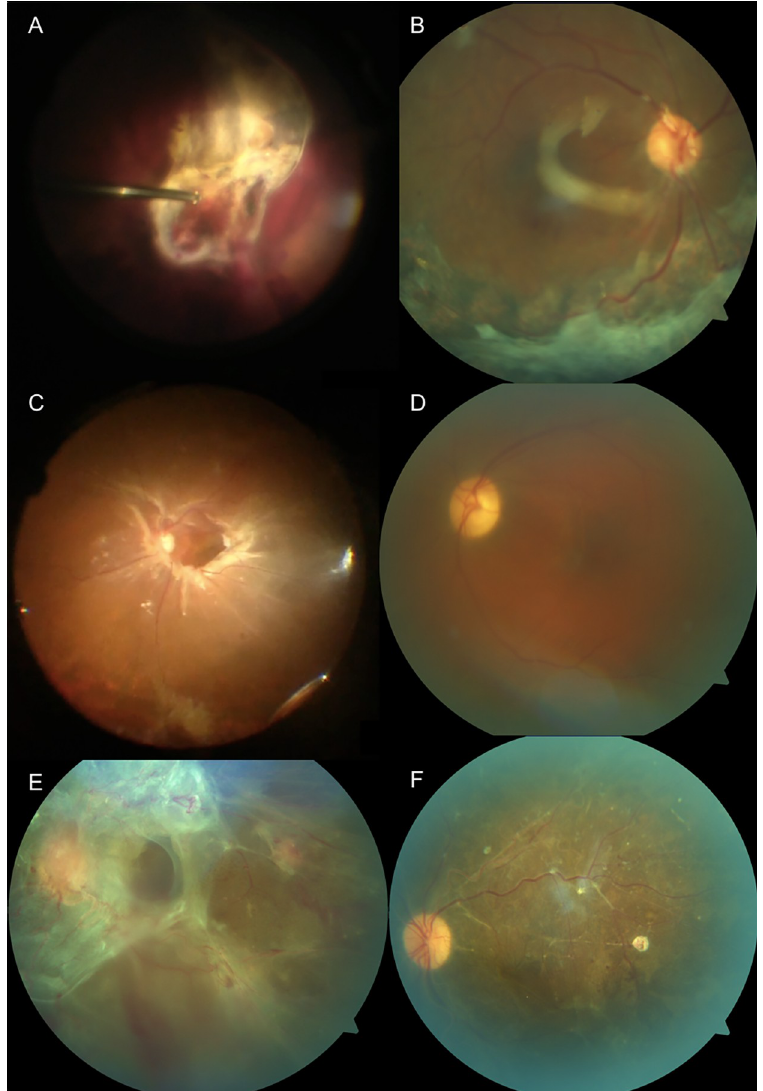
Fig 1. Fundus photographs of advanced diabetic tractional retinal detachments repaired with surgery. (A-B) Intraoperative and postoperative fundus photos in a 50 y/o male with 20-year history of type 2 diabetes mellitus who presented with combined tractional and rhegmatogenous retinal detachments (TRD/RRD) with extensive fibrovascular plaques covering the posterior pole and inferior retina. (C-D) Intraoperative and postoperative fundus photos in a 50 y/o male with 5-year history of diabetes mellitus with combined TRD/RRD and ring of fibrovascular membrane along arcades. (E-F) Preoperative and postoperative fundus photos in a 30 y/o female patient with history of type I diabetes mellitus that presented with chronic macula off TRD with extensive preretinal fibrovascular proliferation. Vision improved from count fingers to 20/80